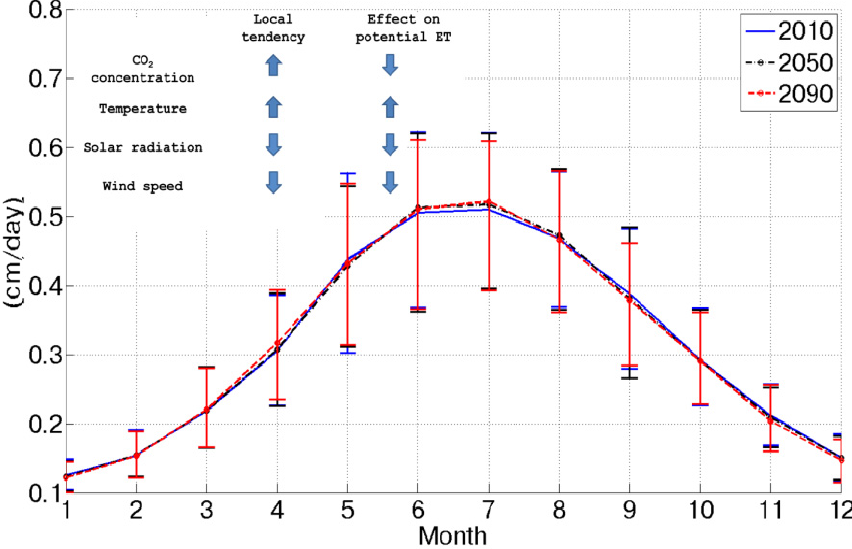
Figure 2. Mean daily potential evapotranspiration for each month in the three considered scenarios. The inset summarizes the local tendencies of the considered variables and the qualitative effect on potential